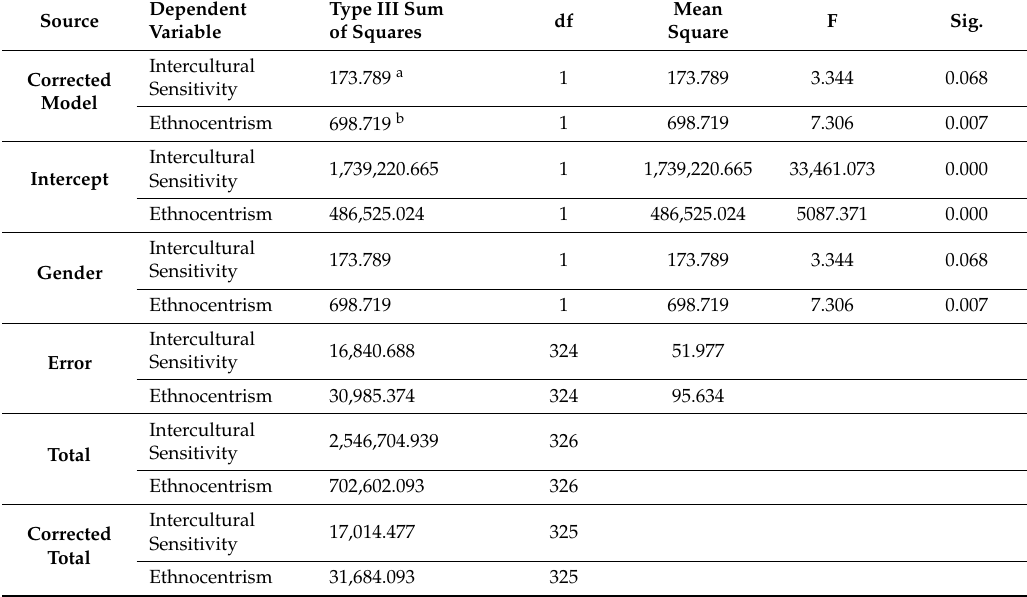
Table 4. The interaction between the gender of the theology students and Intercultural Sensitivity and Ethnocentrism.